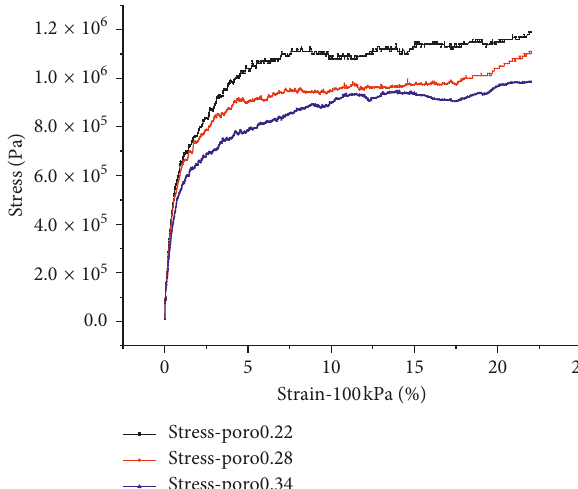
Figure 10: Comparison of triaxial test data [12] and simulation results for sandy